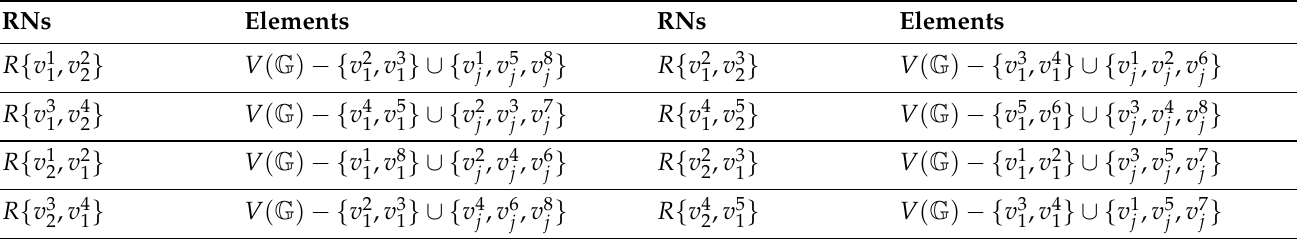
Table 18. RNs ´ R u for 82 ≤ u ≤ 89 and 2 ≤ j ≤